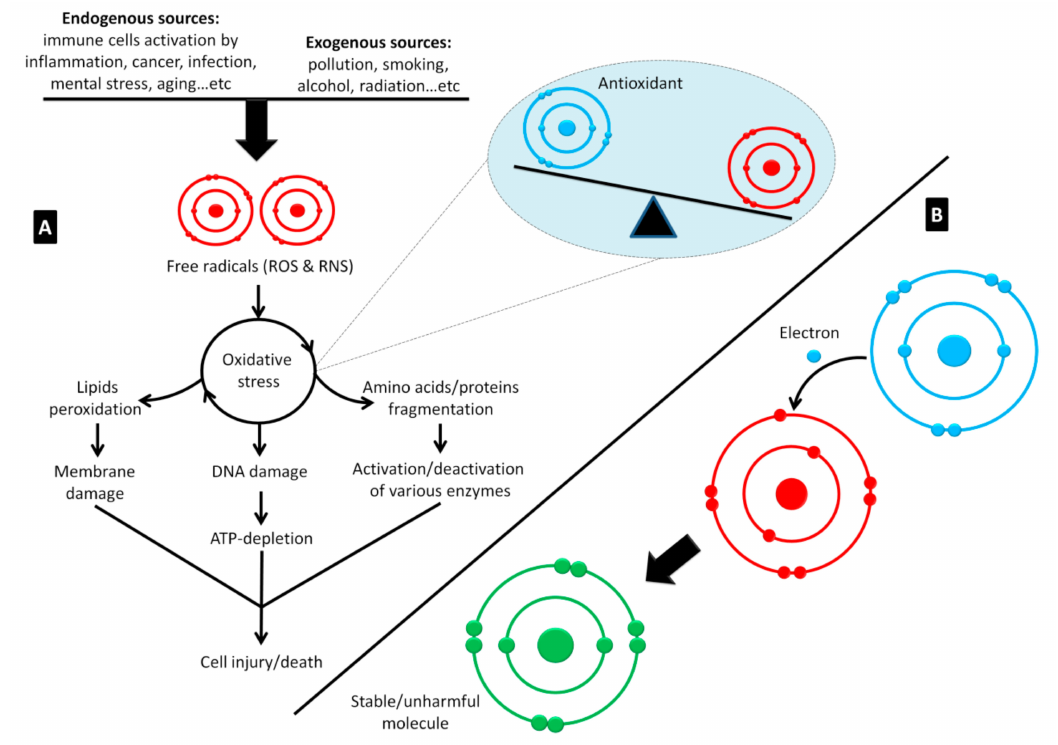
Figure 3. The principal of oxidative damage and the role of antioxidants in scavenging free radicals. ( A ) The free radicals generated from endogenous sources, at limited concentrations, are considered important for regulation of cell maturation, in addition to their role in immune defense. Excessive concentrations of these unstable molecules can result from illness conditions and exogenous sources, and thus lead to oxidative damage (imbalance between free radical and antioxidant concentrations). This status results in cell injury / death based on the extremely high reactivity of free radicals with vital cellular molecules including lipids, amino acids, proteins, and DNA. ( B ) Antioxidants are necessary to stop oxidative damage by neutralizing free radicals. They own this unique role due to their capability to give an electron to free radicals that have unpaired electrons to make them stable and unharmful. ROS, reactive oxygen species; RNS, reactive nitrogen species (adapted from Al-Hatamleh et al., 2020 [36]). According to the current literature, the severity of COVID-19 infection correlates with lymphocytopenia, and patients who died from COVID-19 had lower lymphocyte counts compared to survivors [46,47]. These data suggest that lymphocyte-mediated antiviral activity is poorly e ff ective against COVID-19. Despite lymphocytopenia, evidence for an exaggerated release of pro-inflammatory cytokines (i.e., IL-1 and IL-6) has been reported in the course of acute respiratory syndrome in COVID-19 infected patients, aggravating the clinical course of the disease [48]. Therefore, honey is anticipated to play a vital role in boosting the immune system as a supportive treatment for patients infected with COVID-19, and also for preventive measures for healthy individuals (Figure